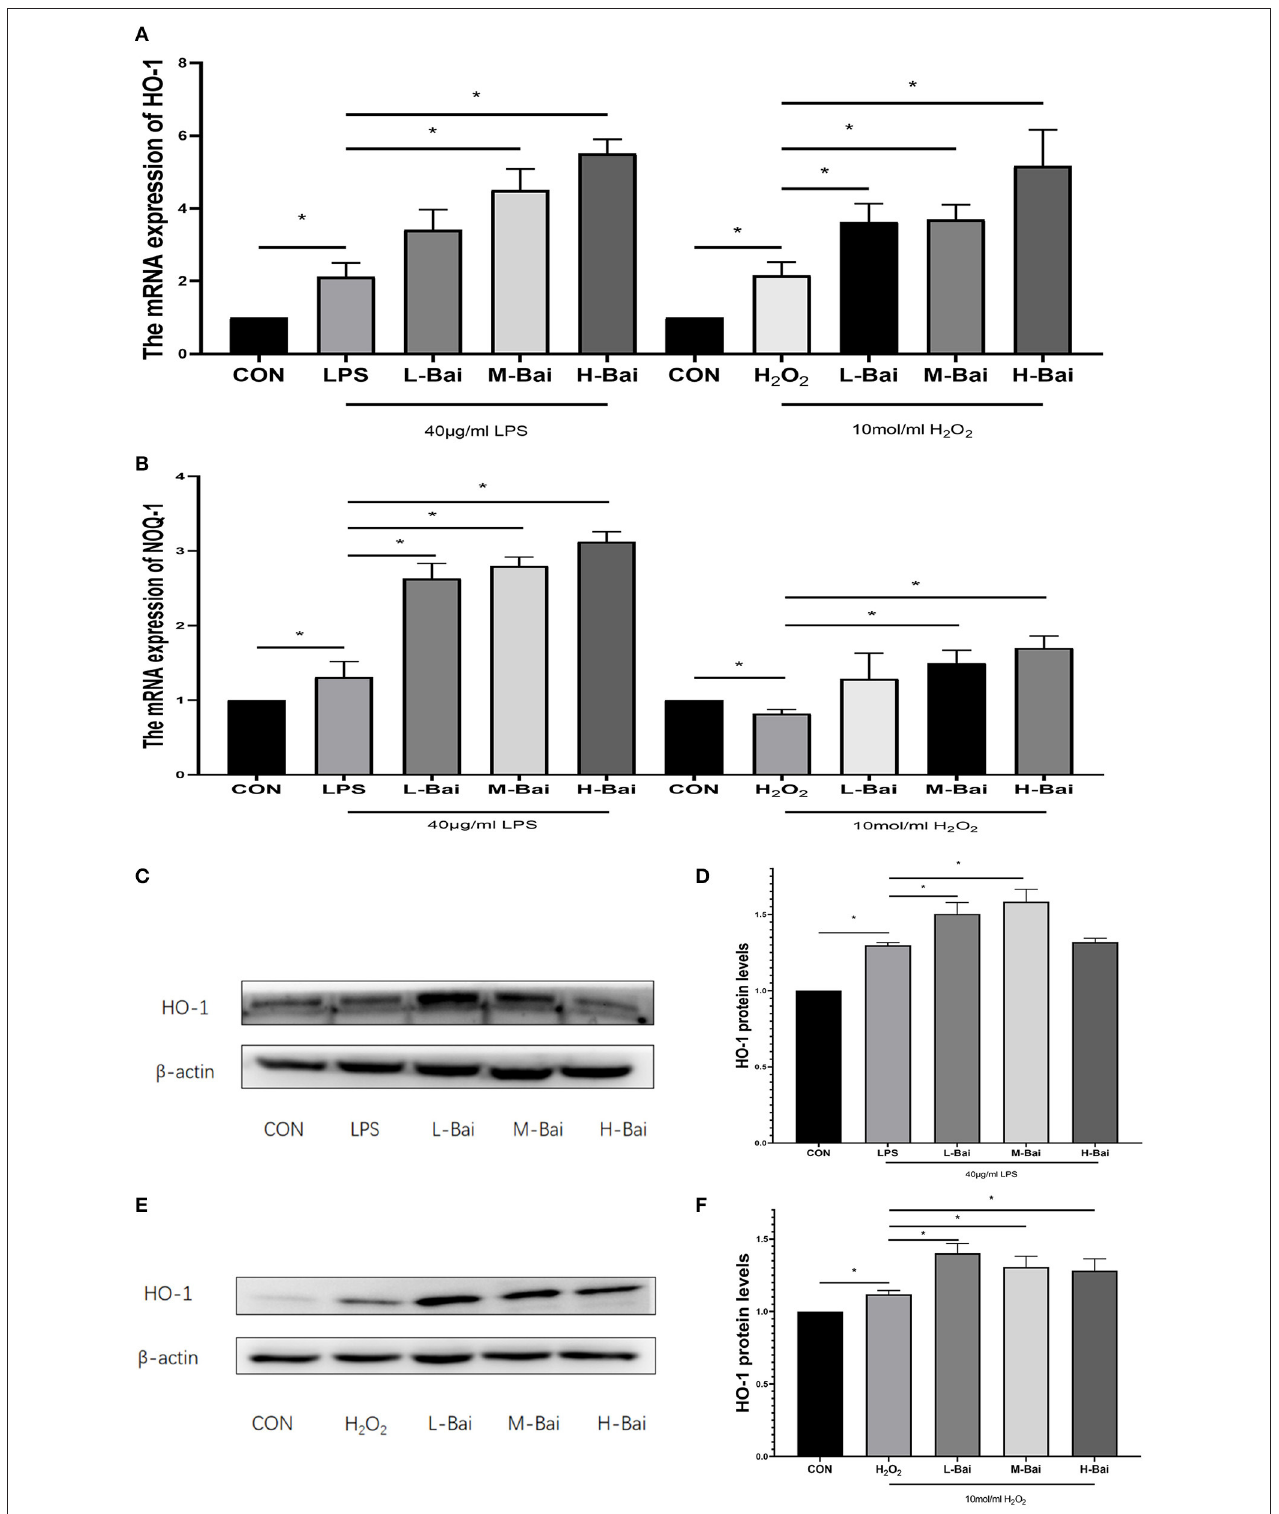
FIGURE 5 | Effects of baicalin on key proteins and mRNAs in the Nrf2 signaling pathway in IPEC-J2 cells. Effect of baicalin on HO-1 mRNA expression in IPEC-J2 cells stimulated by LPS and H 2 O 2 as determined by qPCR (A) . Effect of baicalin on NQO-1 mRNA expression in IPEC-J2 cells stimulated by LPS and H 2 O 2